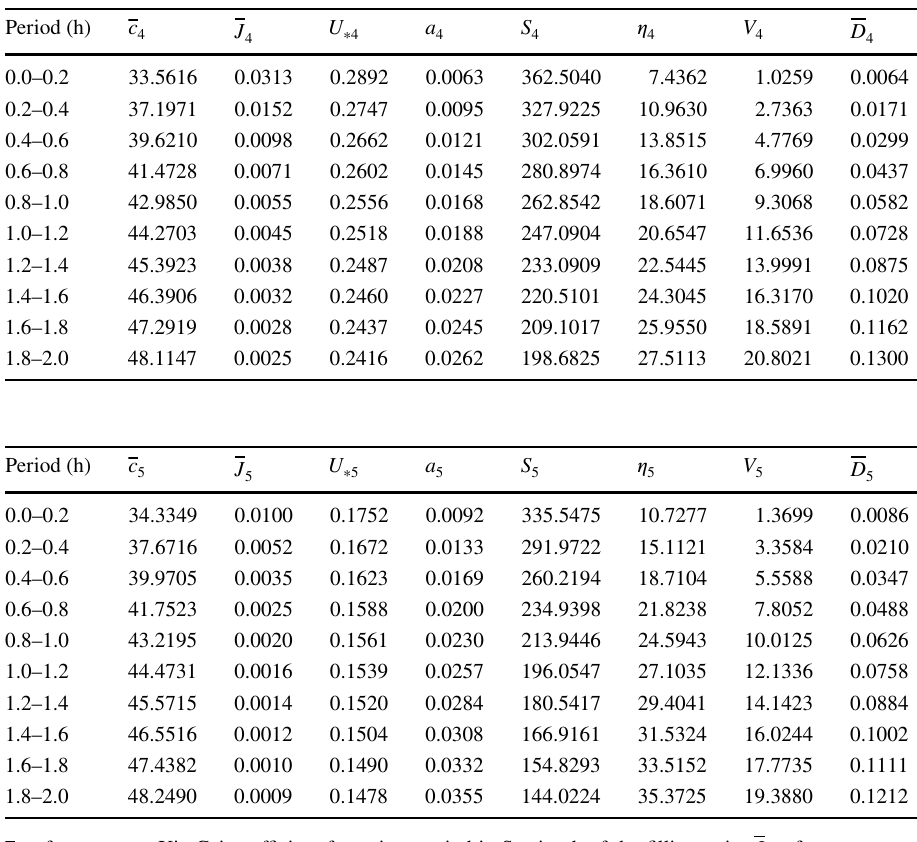
Table 6 Hydraulic parameters, sediment settling rates and average siltation thickness values of the fourth calculation segment